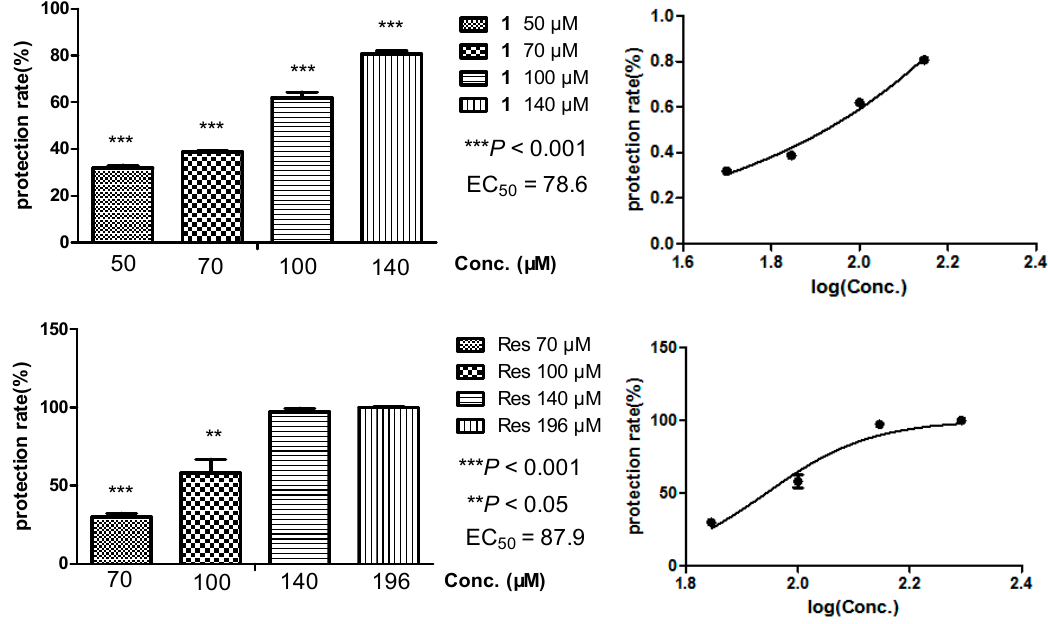
Figure 4. Erythrocyte membrane protection rate (%) of arahypin-16 ( 1 ) and resveratrol (Res) against hemolysis induced by AAPH.